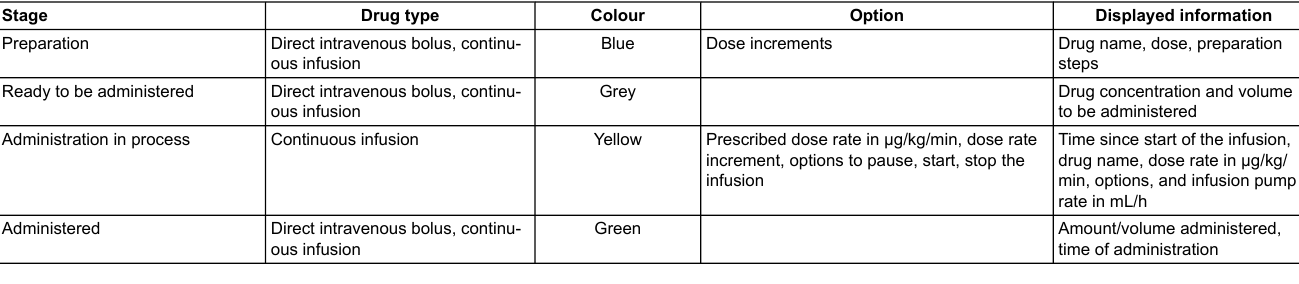
Amount/volume administered, time of